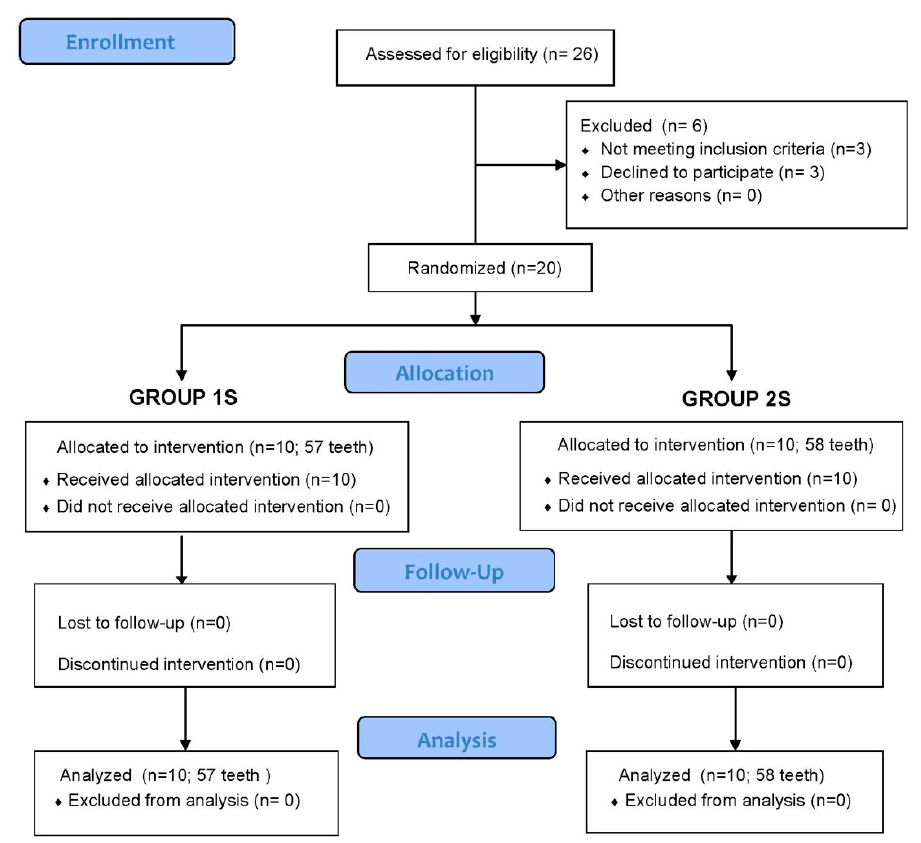
Figure 2. Flow diagram of the trial.